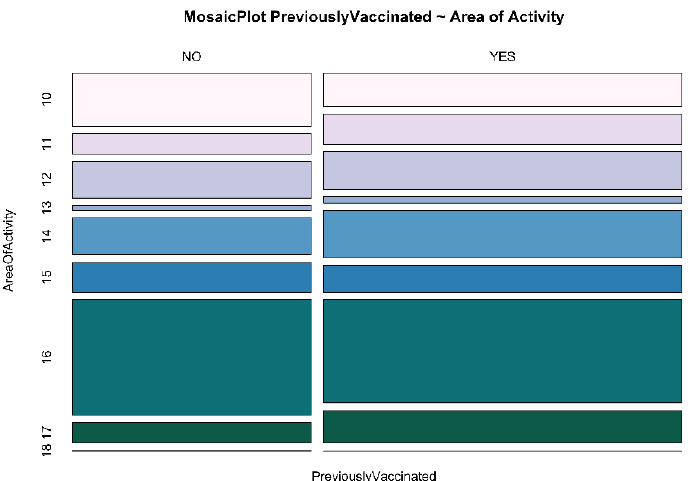
Figure 4. Comparison between area of activity and previous influenza vaccination. Area of activity: 10 Administrative; 11 Newborn; 12 Pediatric; 13 General Surgery; 14 Specialist Surgery; 15 General Medicine; 16 Specialist Medicine; 17 Intensive Care Unit; 18 Missing Data.